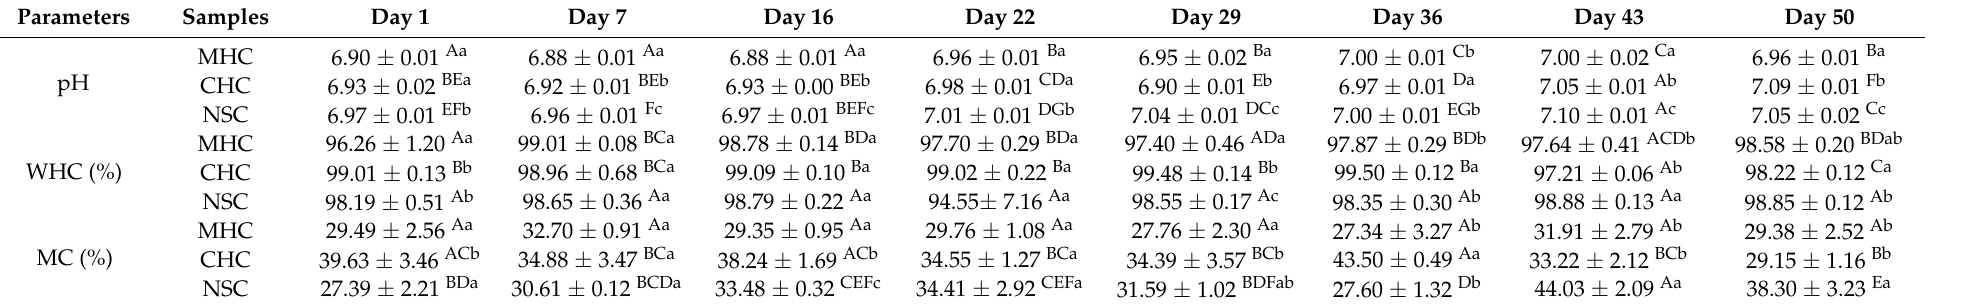
Table 1. Chemical property comparison for sausages with different casings during 50 days of cold storage (4 ◦ C).